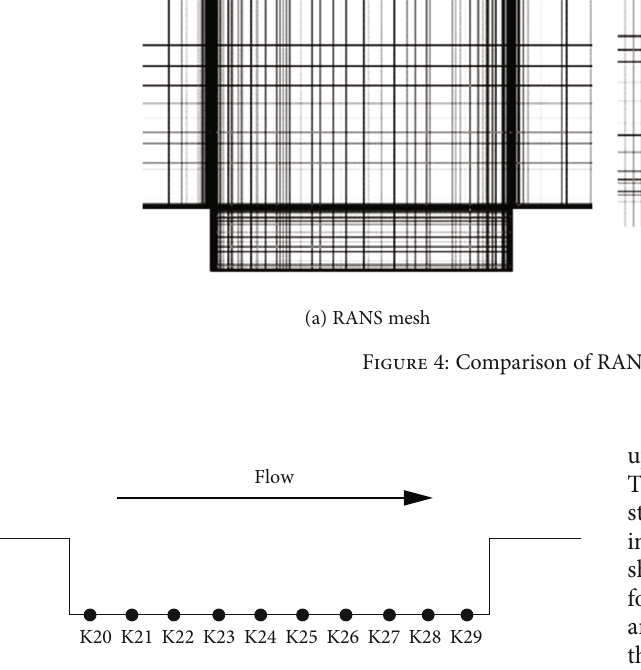
Figure 5: Monitoring locations of oscillating